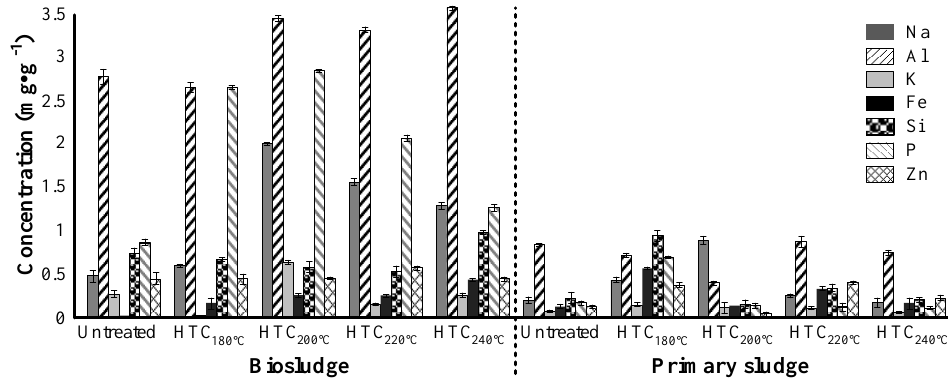
Figure 3. Inorganic elements in feedstock and hydrochar BS and SP samples.